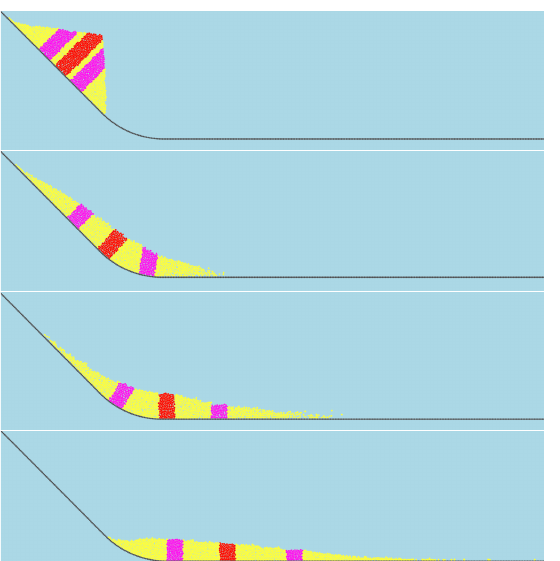
Figure 2. Successive snapshots of the flow of a granular mass ( N p = 1452). In red and pink are shown the neighbourhood of the main, and upstream and downstream secondary centres of gravity G , G 0 and G 00 , over which mean quantities are evaluated.